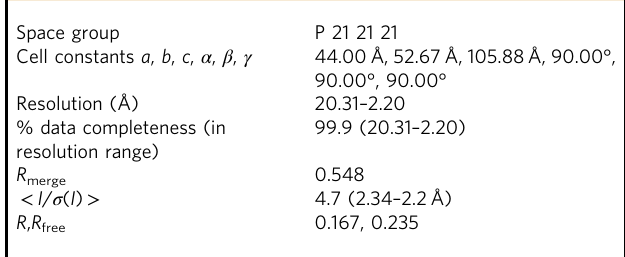
Table 1 Ligand structures and their hypercalcemia liability activities